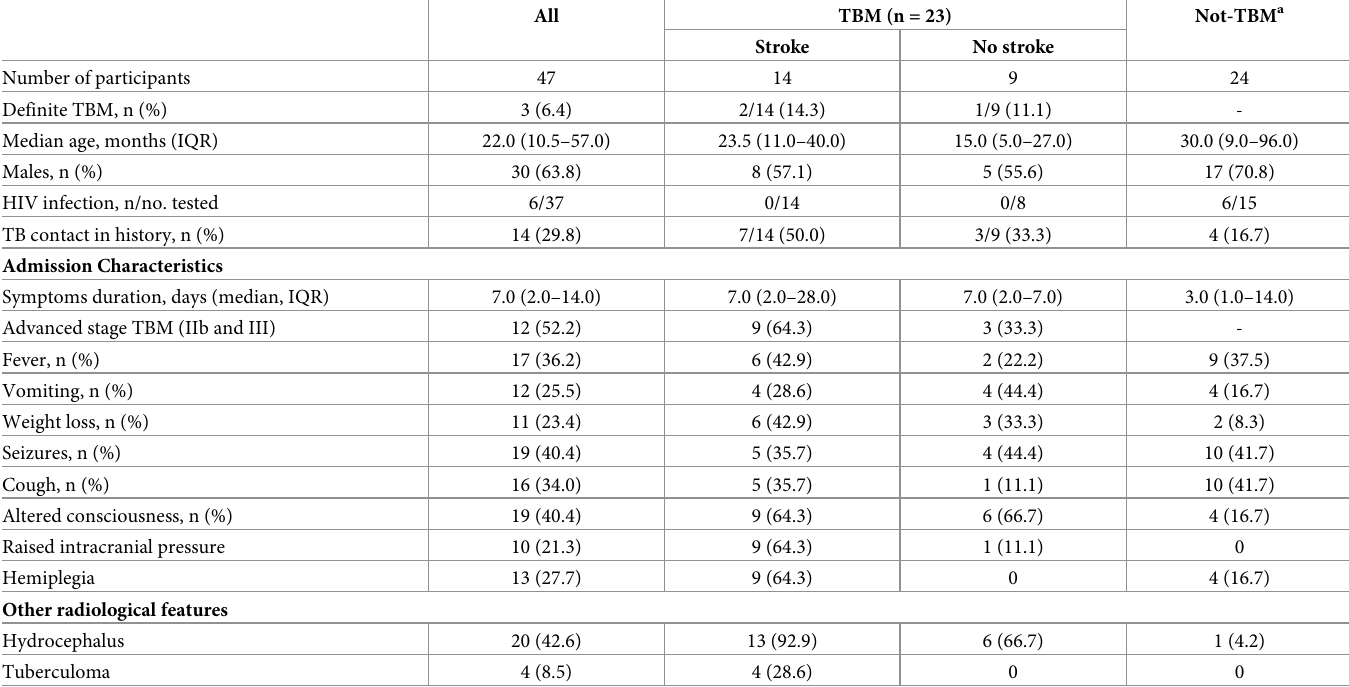
Table 1. Clinical and demographic characteristics of the study participants.